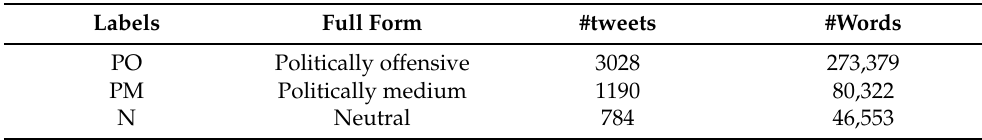
Table 5. Roman Urdu Political Hate Speech (RU-PHS) dataset characteristics